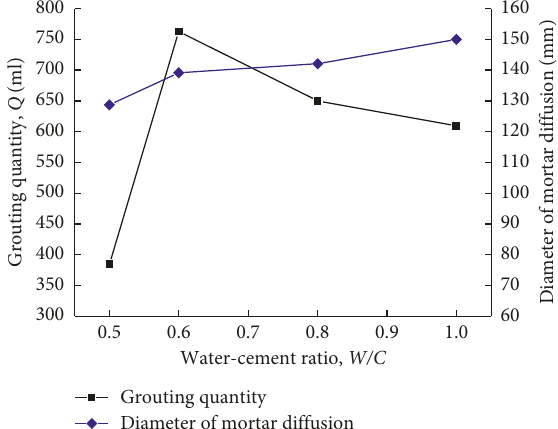
Figure 16: Characteristics of slurry diffusion ( P � 0.4 MPa, k 1 � 0.11cm/s).